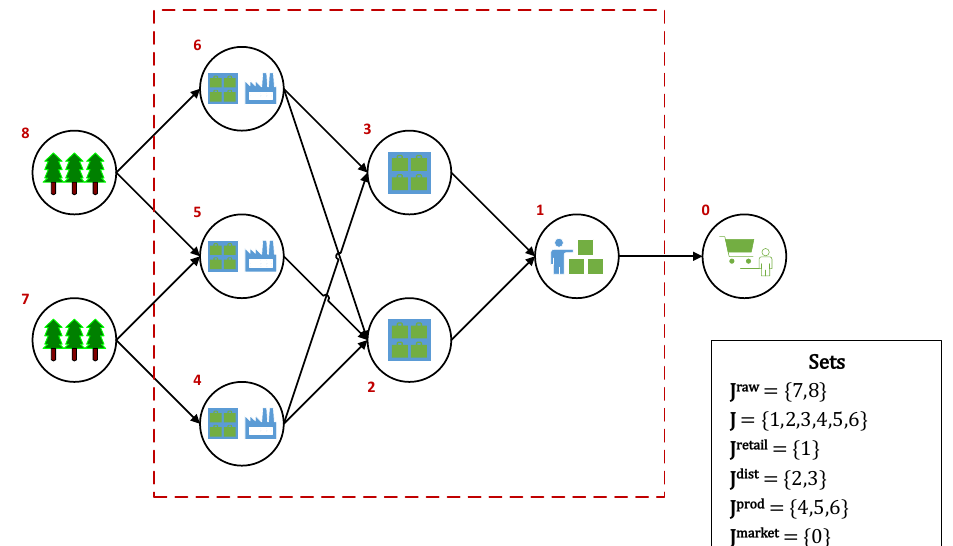
Figure 1. Supply Chain Network